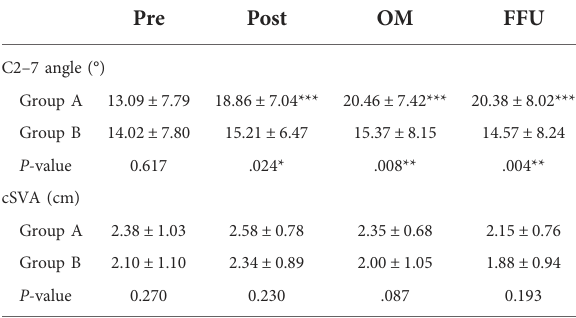
TABLE 3 Comparison of the C2 – 7 angle and cSVA between the two groups.